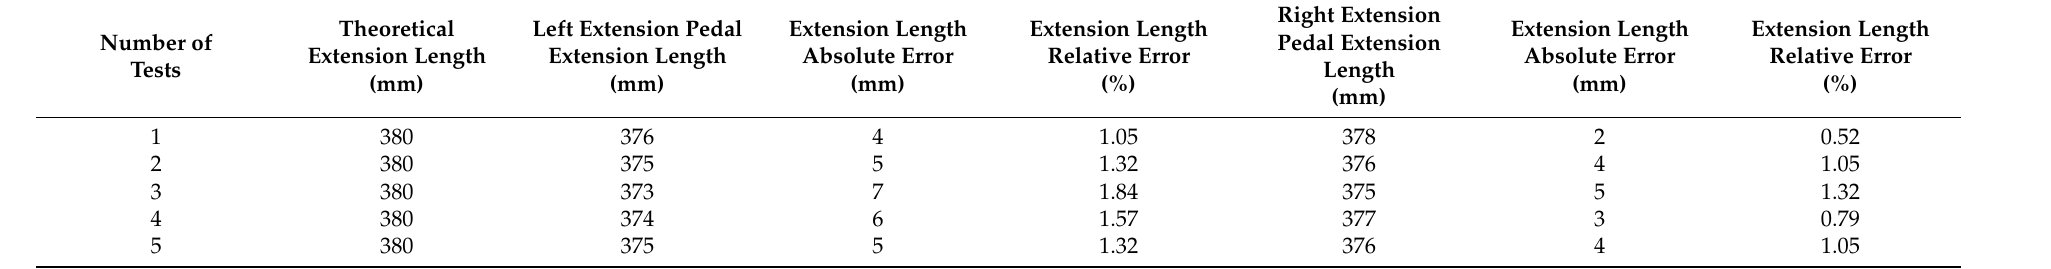
Table 13. Pedal extension